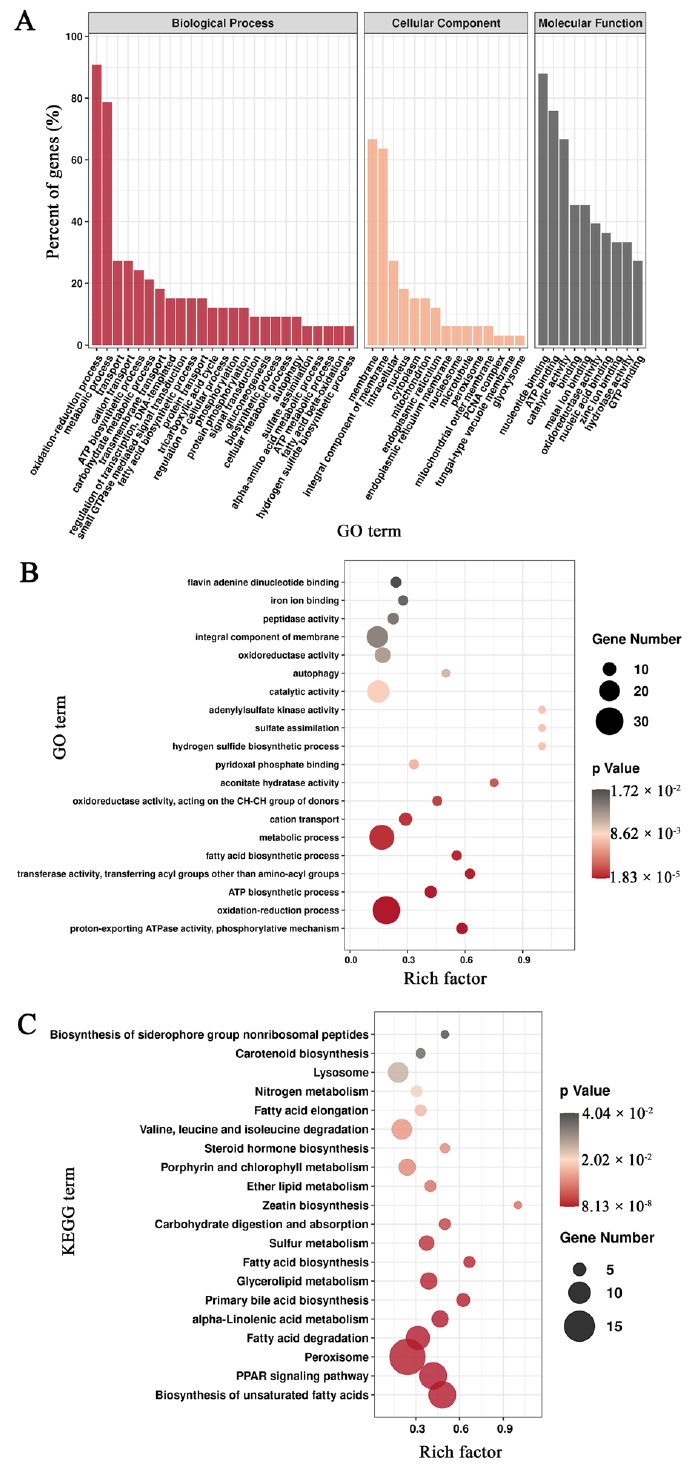
Figure 8. GO ( A , B ) and KEGG ( C ) enrichment analysis of differentially expressed genes (DEGs) derived from the three groups (i.e., TA, TB, and TC) of Mortierella alpina.